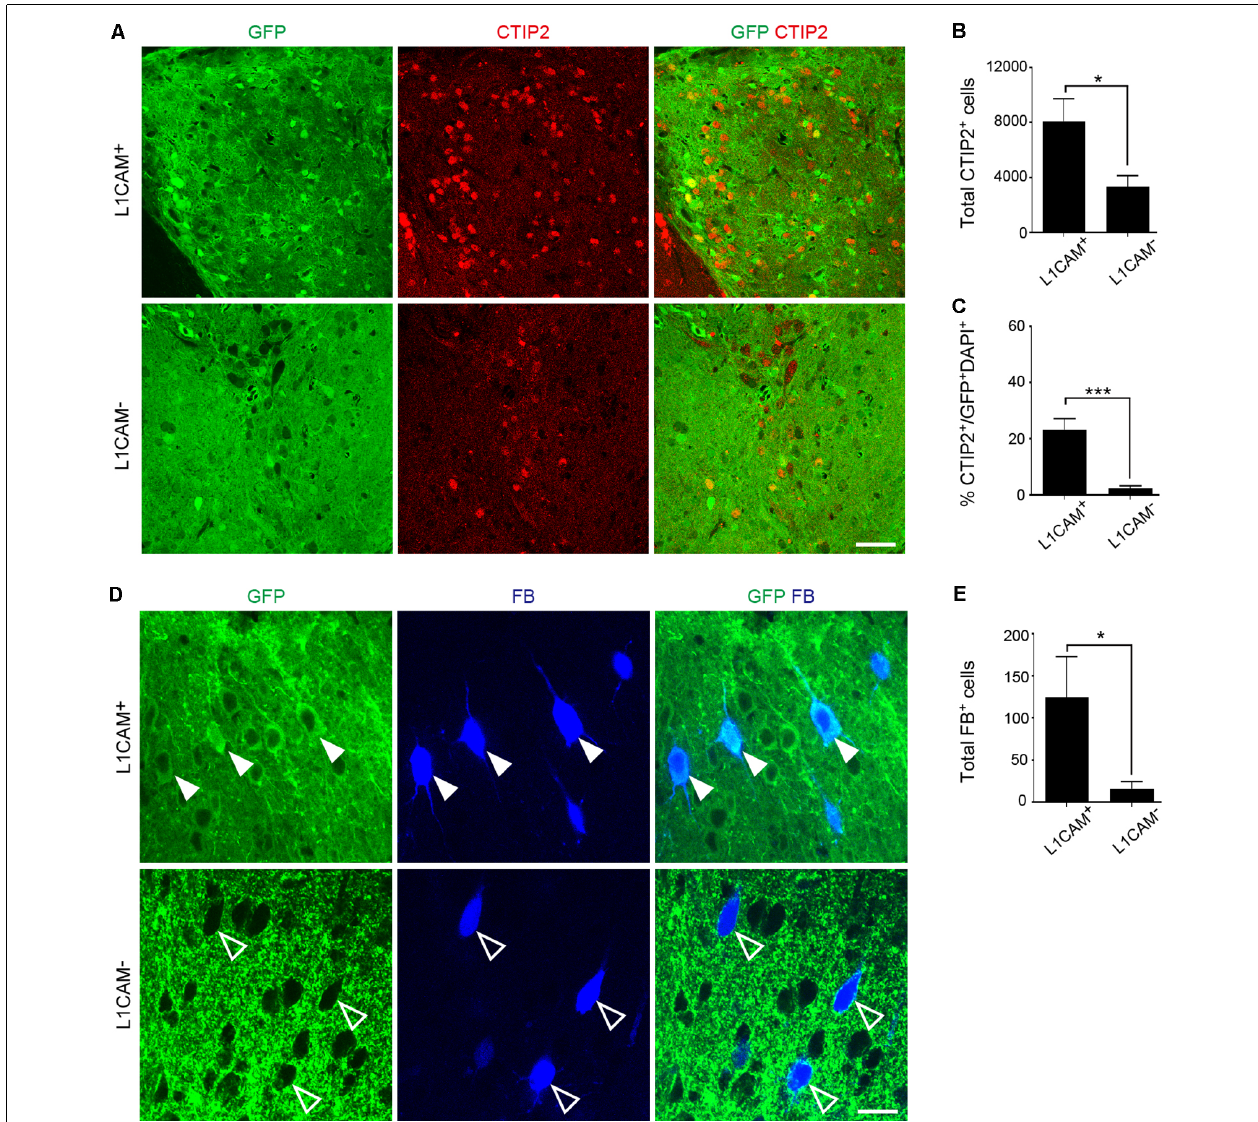
FIGURE 6 | L1CAM + grafts have a character consistent with CSMNs. L1CAM + cells and L1CAM − cells were isolated from E14.5 mouse frontal cortex, and 2 days later they were injected into the adult brain for 2 months. (A) Immunofluorescence images of the graft for GFP (green) and CTIP2 (red). Scale bar represents 50 µ m. (B) Total number of CTIP2 + cells in the L1CAM + grafts and L1CAM − grafts (L1CAM + : n = 6 and L1CAM − : n = 6). (C) Percentage of CTIP2 + cells in total cells stained with DAPI and GFP (L1CAM + : n = 6 and L1CAM − : n = 6). (D) Immunofluorescence images of graft for GFP (green) and FB (blue). FB was injected into the pyramidal decussation 7 days before sacrifice. Solid white arrowheads represent graft-derived cells. Open arrowheads represent host-derived cells. Scale bar represents 25 µ m. (E) Total number of FB + cells in L1CAM + grafts and L1CAM − grafts (L1CAM + : n = 6 and L1CAM − : n = 6). All values are displayed as means ± SEM. Student’s t -test, * P < 0.05 and *** P <